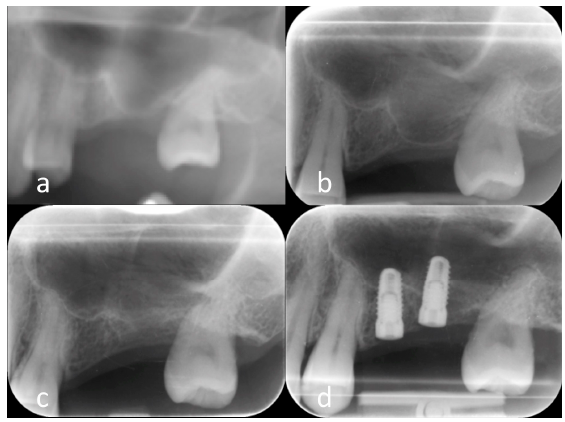
Figure 4. PLGA group. ( a ) Magnification of panoramic radiograph of left sinus showing a residual bone height insufficient to implant positioning; ( b ) periapical X-ray of the same site of ( a ) immediately after sinus floor elevation surgery; ( c ) periapical X-ray of the same site of ( a ) six month after sinus floor elevation surgery; ( d ) periapical X-ray after implant positioning in the new-formed bone.